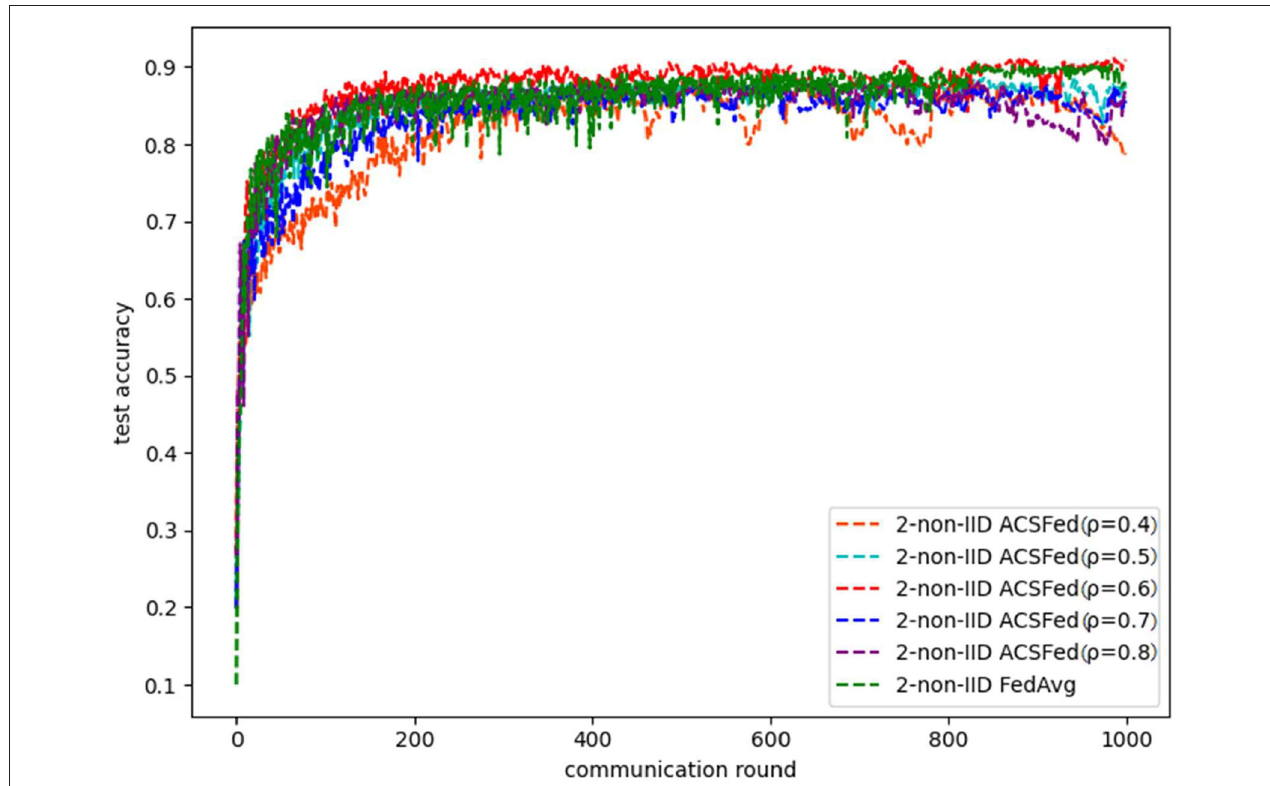
FIGURE 6 | Test accuracy on fashion MNIST in 2-class non-IID